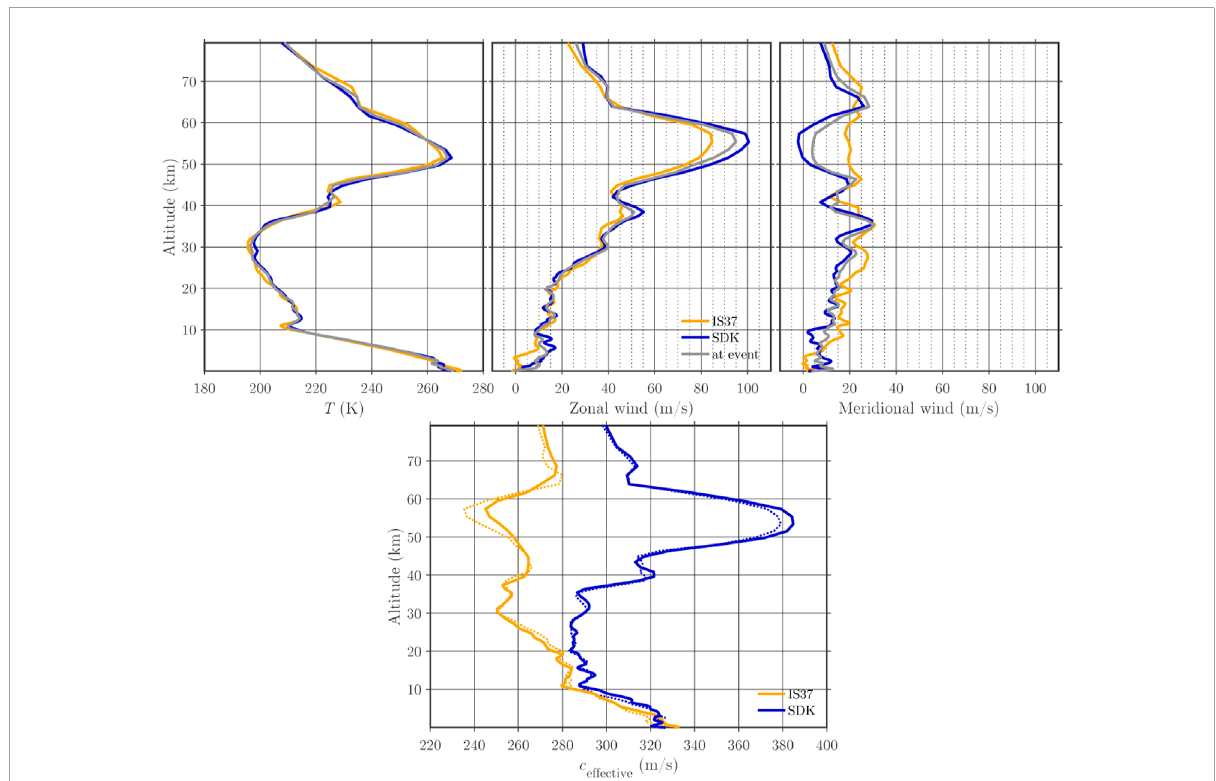
FIGURE 17 ECMWF wind and temperature profiles at the grid points closest to the infrasound stations IS37 and SDK as well as the assumed acoustic event site (top). Effective sound speeds from this event point towards the infrasound stations